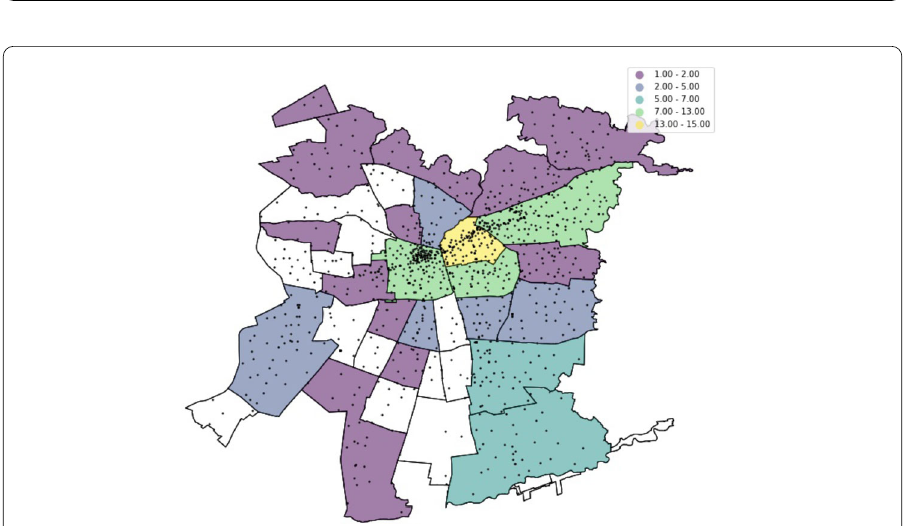
Figure 2 Position of antennas (black dots) and presence of our 65 users in the largest urban area of Santiago de Chile. Antennas cluster in regions with more demand, and become sparser in regions with less demand. The noticeable line of antennas in the middle of the map are those that fall in the wealthier/financial comunas (a large administrative unit, represented in our map with black lines)